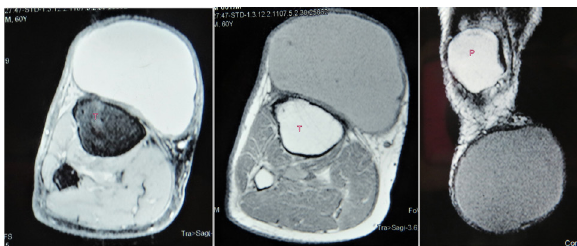
Figure 3. The MRI images of axial cuts inT1 and T2 weighted scans showing a large collection in front of tibia and the same lesion below the patella (Tibia denoted by T and patella by